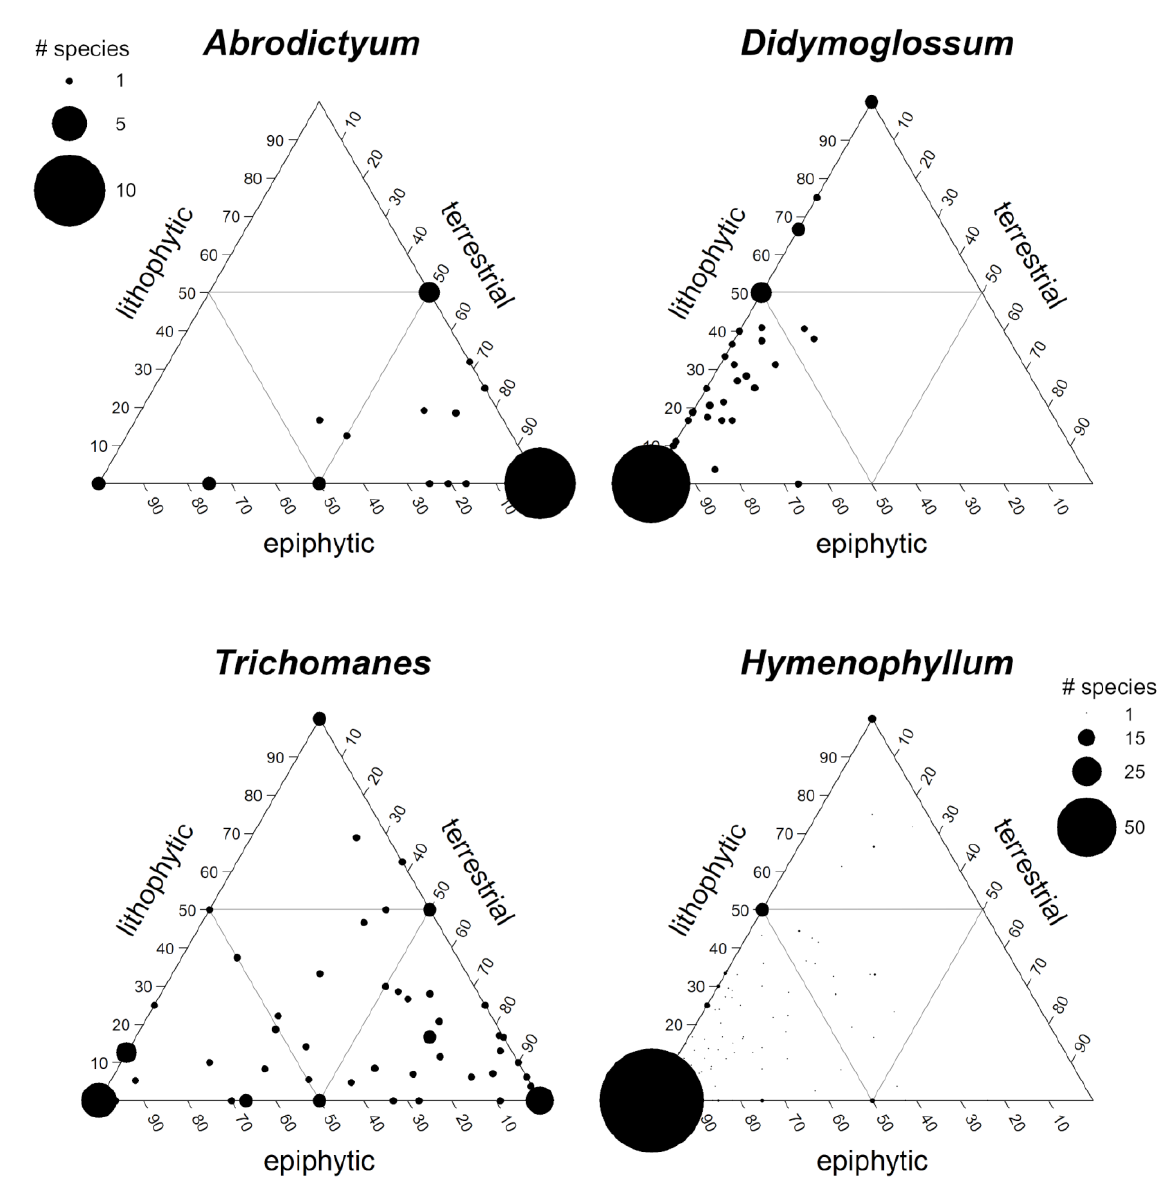
Figure 3. Distribution of 28 Abrodictyum , 47 Didymoglossum, 61 Trichomanes and 233 Hymenophyllum species in the epiphyte-lithophyte-terrestrial space. Symbol size varies with the number of species with the same values of EV, LV and TV. Scaling is identical for Abrodictyum , Didymoglossum and Trichomanes but differs for Hymenophyllum .